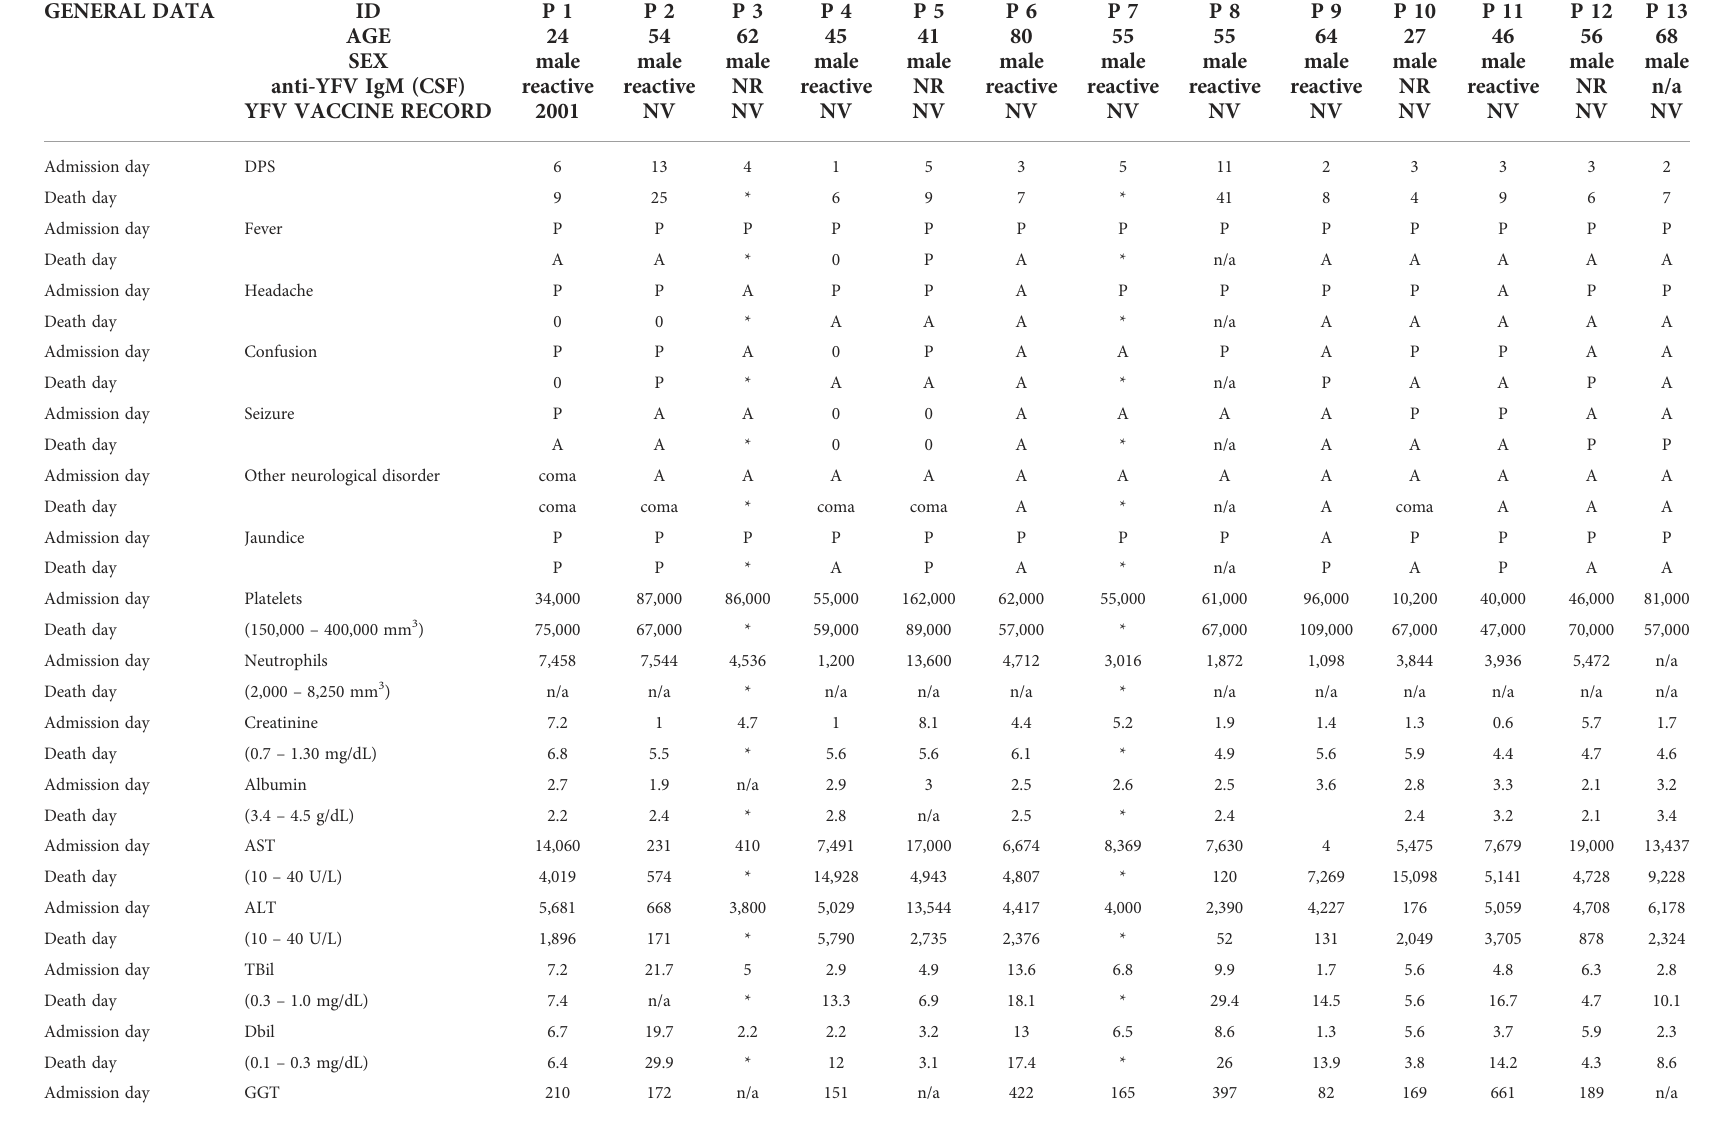
TABLE 2 Clinical data at admission and death day of 13 YF patients analyzed in this